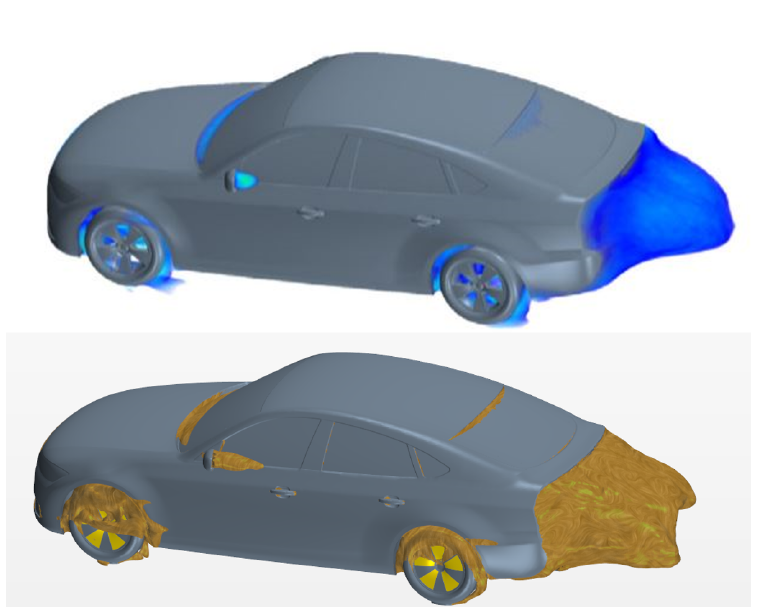
Figure 15. Comparison of regions of separation ( U i < 0) between the current CFD work ( Bottom ) and IDDES simulation of Ashton [48] ( Top